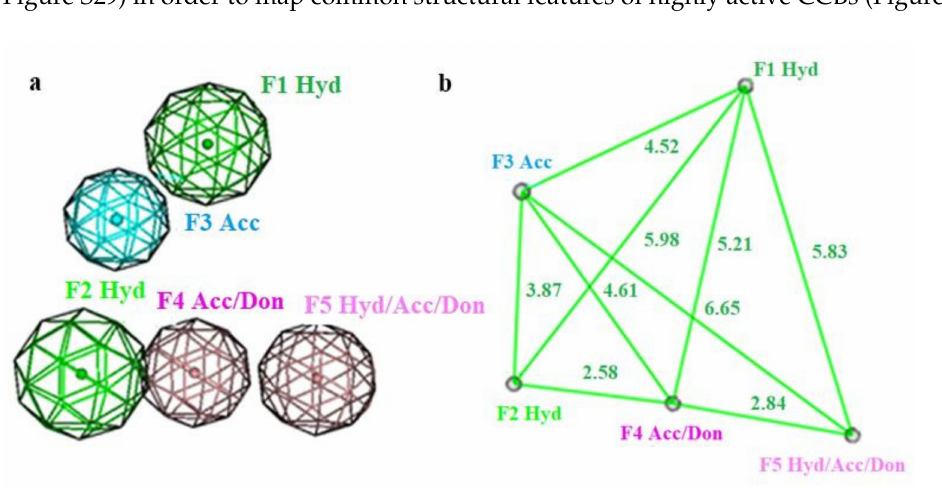
Figure 4. ( a ) The best query displaying pharmacophoric features shared by representative DHP, DHPM and pyrimidine-based CCBs as colored spheres (green for hydrophobic feature, cyan for H-bond acceptor and pink for H-bond acceptor/donor as well as hydrophobic centers with H-bond acceptor or donor functions. ( b ) Linear distances between various pharmacophore features are measured in angstroms and displayed as green